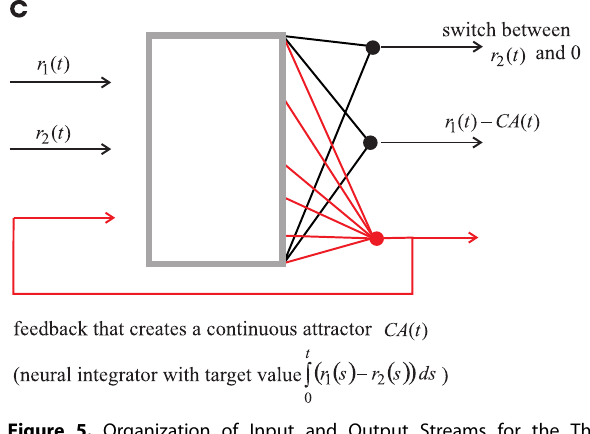
Figure 5. Organization of Input and Output Streams for the Three Computational Tasks Considered in the Computer Simulations Each input stream consisted of multiple spike trains that provided synaptic inputs to individually chosen subsets of neurons in the recurrent circuit (which is indicated by a gray rectangle). (A,C) Input streams consisted of multiple Poisson spike trains with a time- varying firing rate r i ( t ). (B) Input consisted of a burst ( ‘‘ cue ’’ ) in one spike train (which marks the beginning of a time interval) and independent Poisson spike train ( ‘‘ noise ’’ ) in the other input channels. (A–C) The actual outputs of the readouts (that were trained individually for each computational task) is shown in Figures